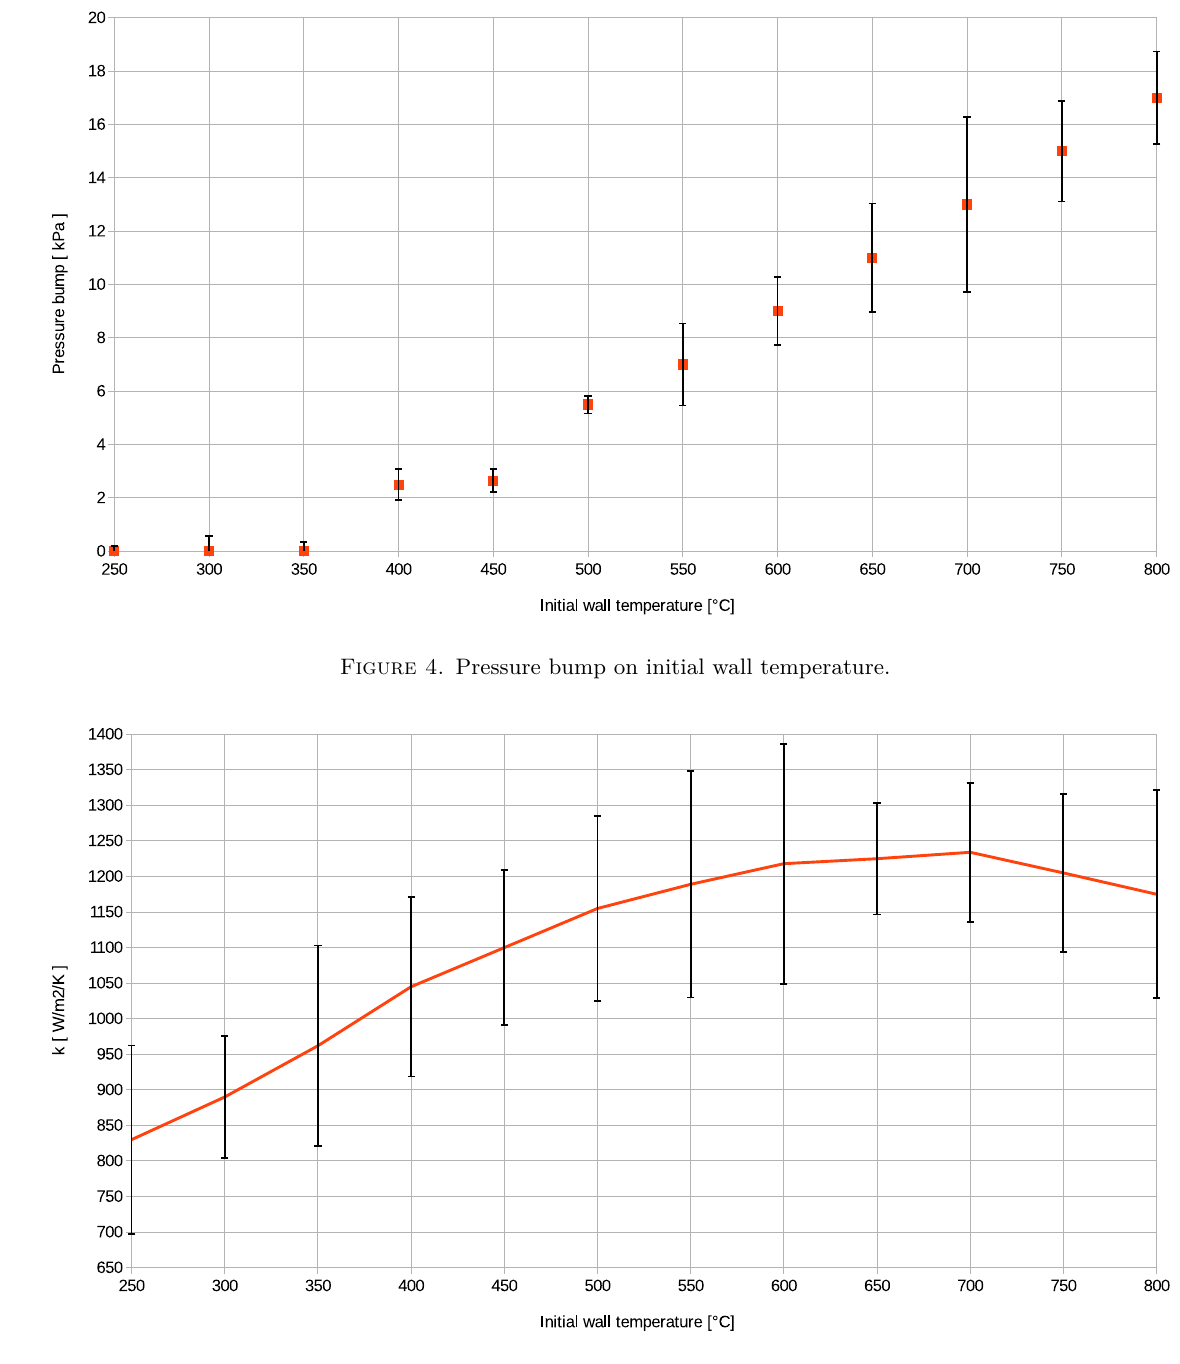
Figure 5. Heat transfer coefficient at the quench front on initial wall